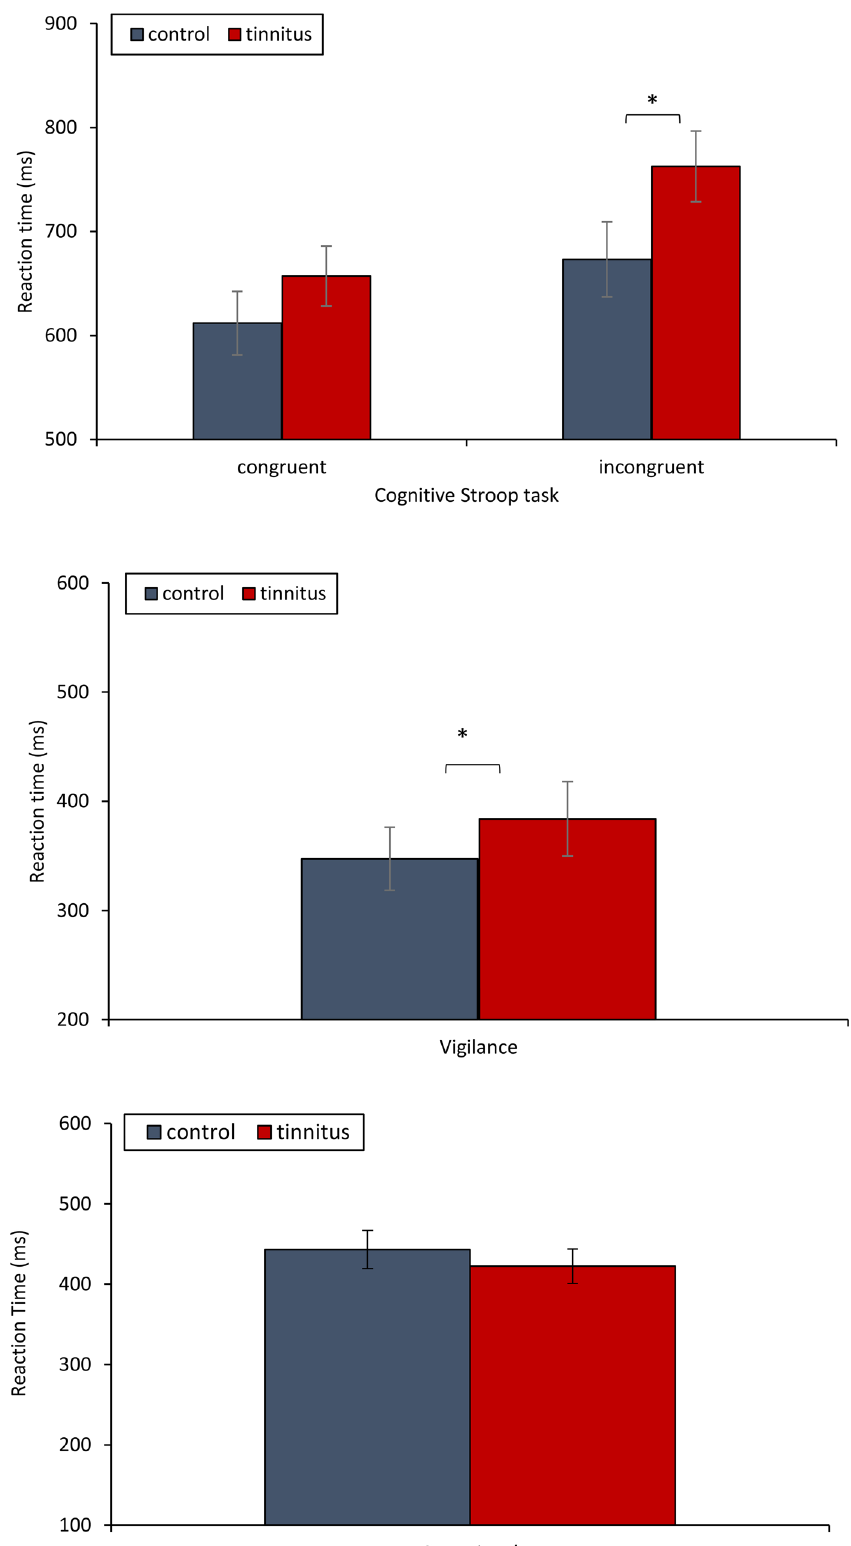
Figure 3. Comparison between control and tinnitus participants in reaction times for the different tasks. ( A ) Cognitive counting Stroop task, ( B ) Vigilance task, and ( C ) Stop-Signal